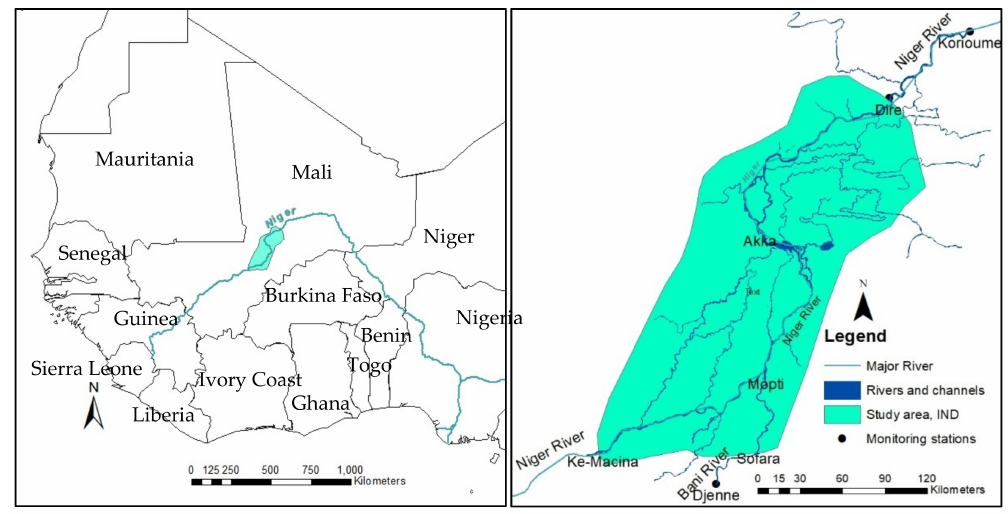
Figure 1. Location map of the study area, the Inner Niger Delta, Mali, West